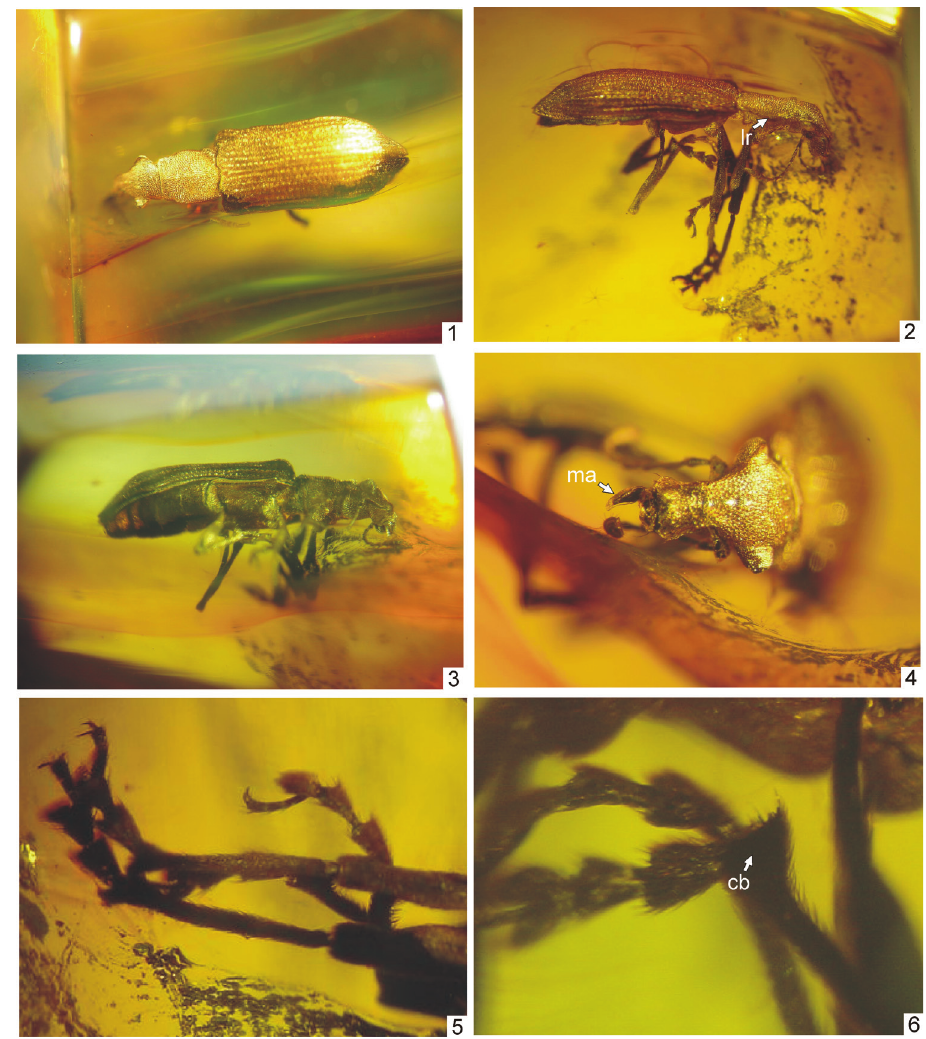
Figures 1–6. Arostropsis groehni gen. et sp.n. 1 body, dorsal view 2 body, lateral view 3 body, ventro- lateral view 4 head, dorsal view 5 protarsi 6 metatibia apex. Abbreviations: cb – corbel, ma – mandibular process. Body length: 6.4